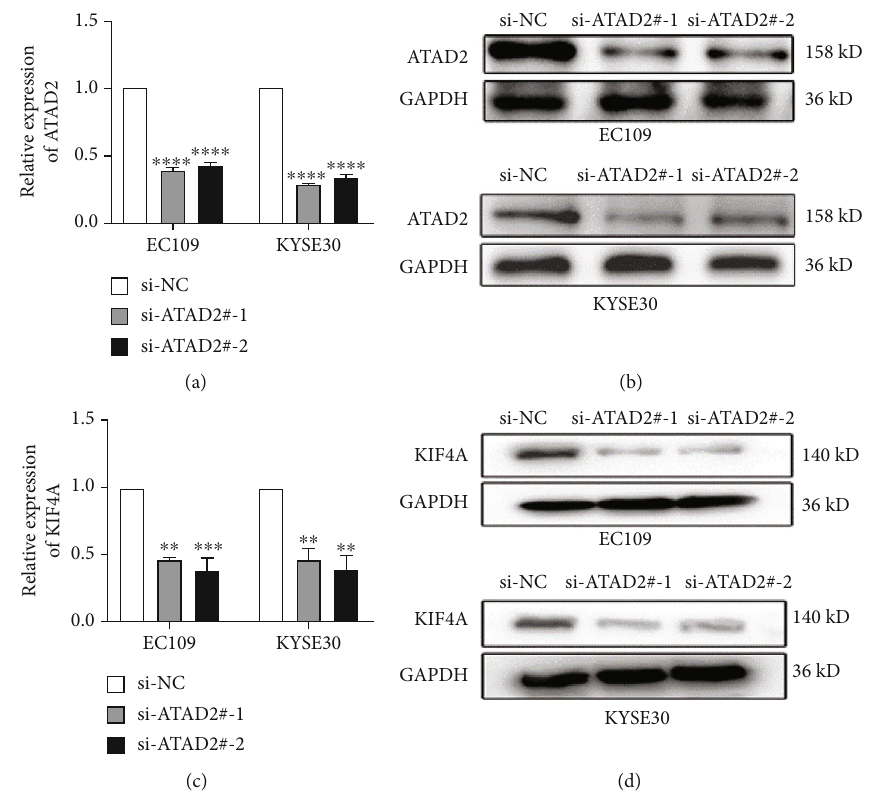
Figure 2: ATAD2-regulated KIF4A expression in ESCC cells. (a and b) The ATAD2 expression of si-ATAD2#1 and si-ATAD2#2 groups were signi fi cantly decreased compared with that of si-NC group in both mRNA and protein levels. (c and d) The KIF4A expression levels in both mRNA and protein level of EC109 and KYSE30 cells were suppressed in si-ATAD2#1 and si-ATAD2#2 groups. ∗∗ P < 0 : 01 , ∗∗∗ P < 0 : 001 , and ∗∗∗∗ P < 0 : 0001